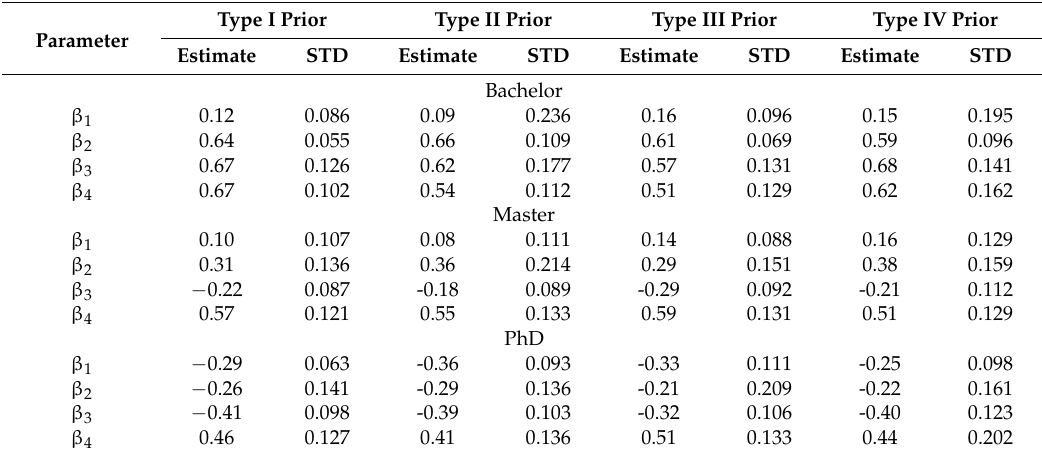
Table 6. Model parameter estimates and standard errors for four types of prior